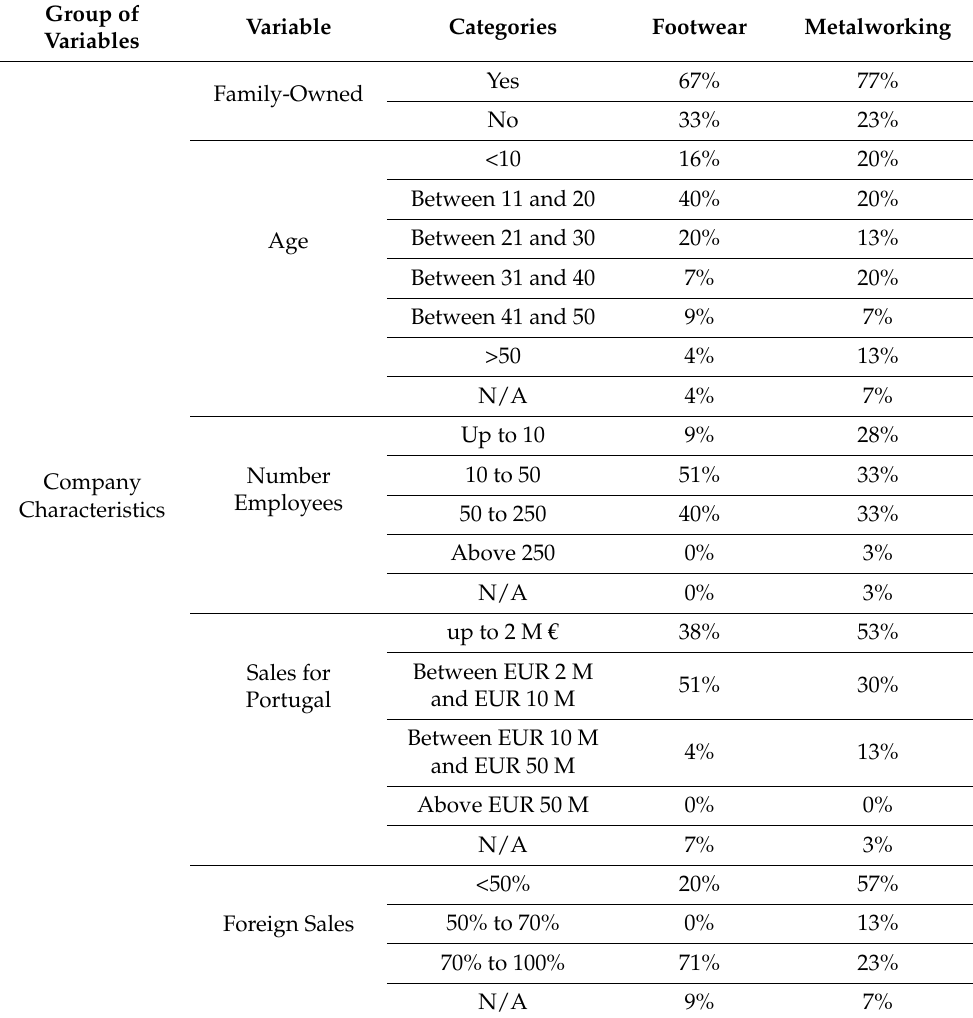
Table 1. Descriptive characteristics of the